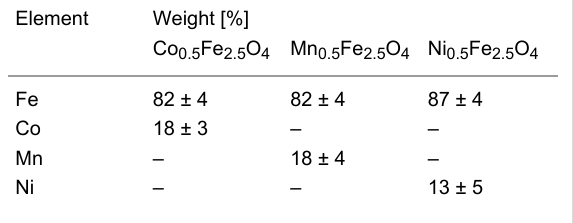
Table 2: Elemental composition of the tested ferrite